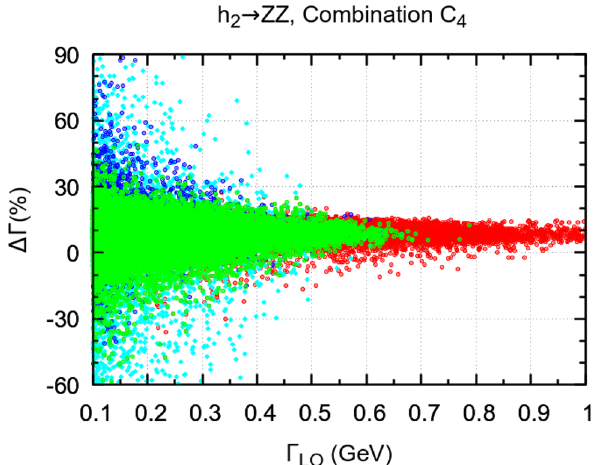
Figure 3 . ∆Γ h in percentage as a function of Γ LO , for the combination C 4 . Only h 2 → ZZ 2 → ZZ the interval 0 . 1 GeV < Γ LO < 1 GeV is shown. In red/dark-gray, points with µ R = 350 GeV passing all constraints except HiggBounds-5 . The remaining colors represent different values of the renormalization scale for points passing all the constraints: in cyan/light-gray, µ R = 125 GeV; in green/gray, µ R = 350 GeV; in blue/black, µ R = 700